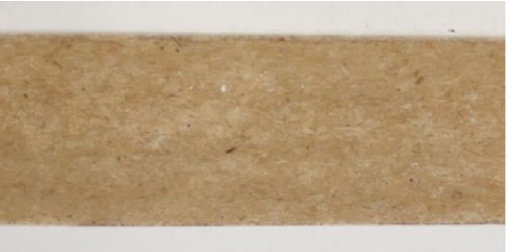
Fig. 18 15 mm wide sample of paper